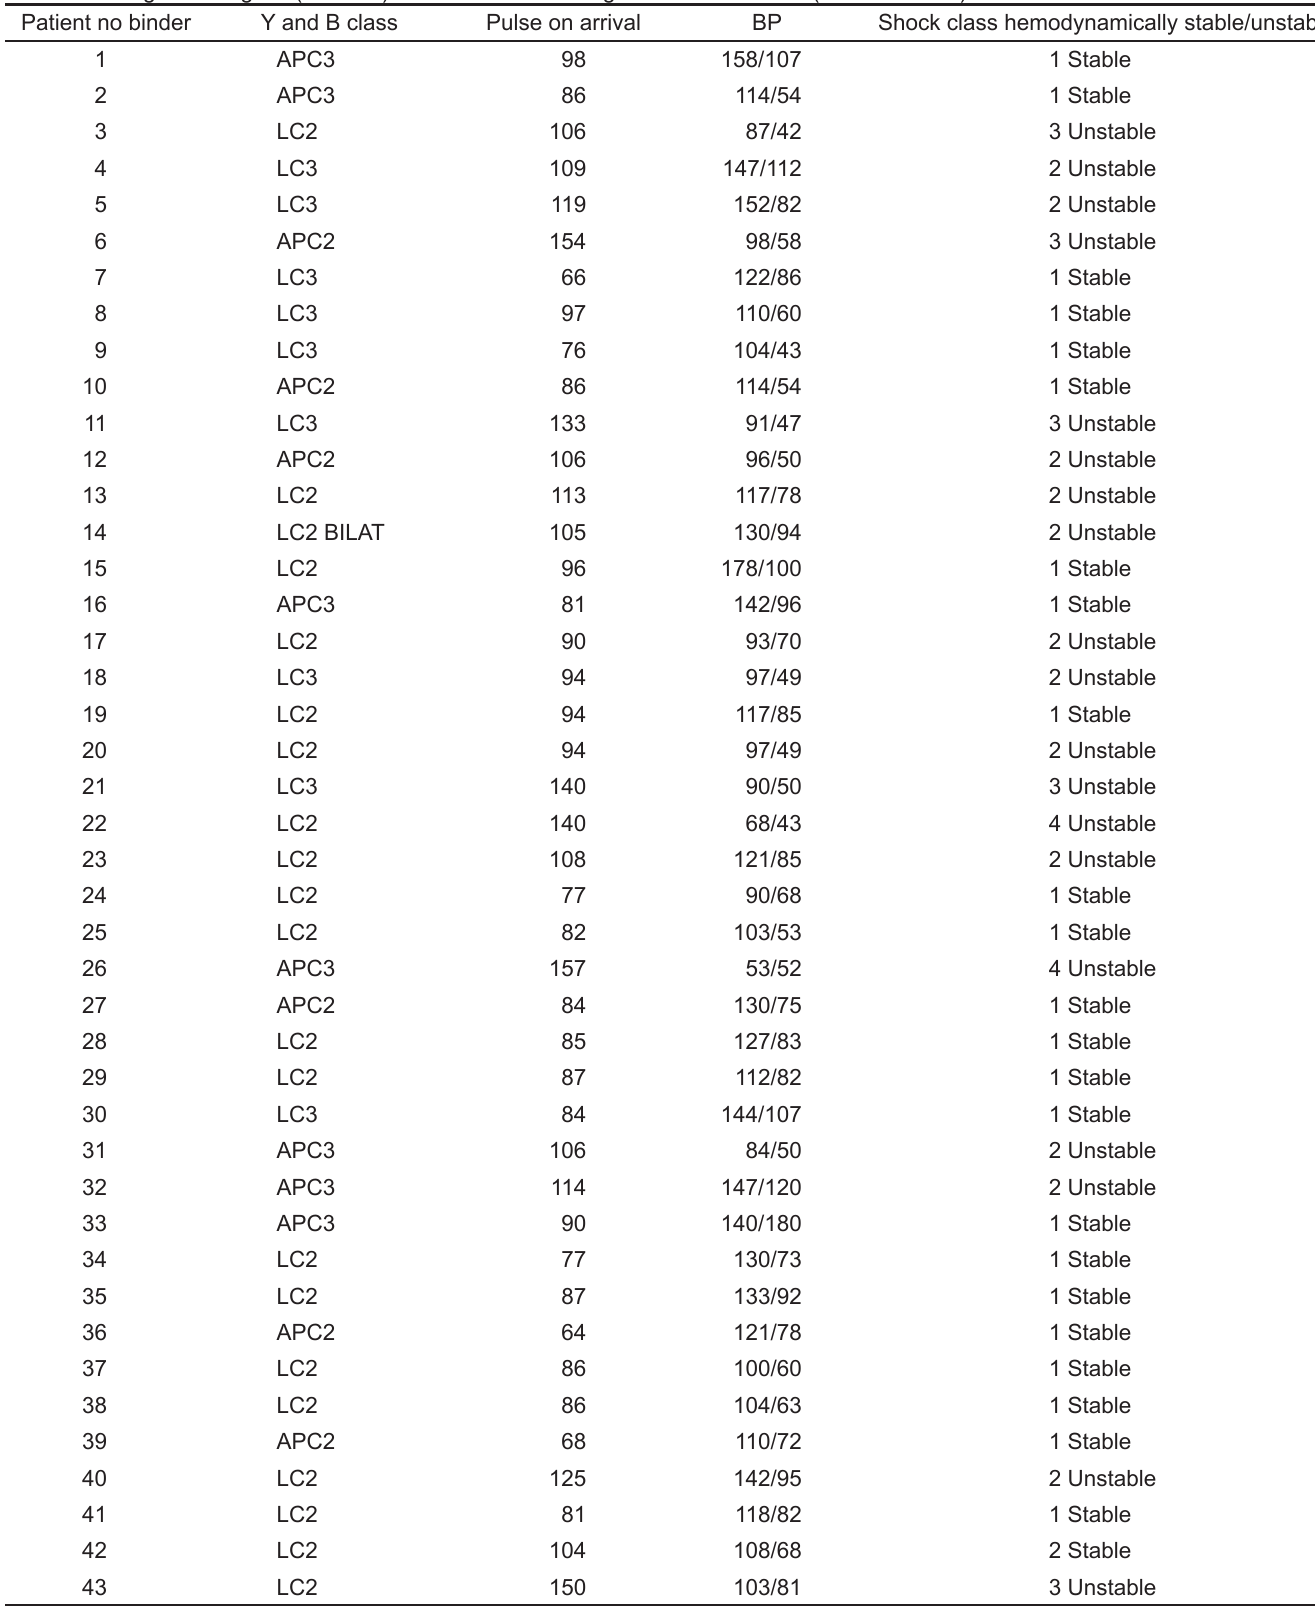
APC, anterior posterior compression; LC, lateral